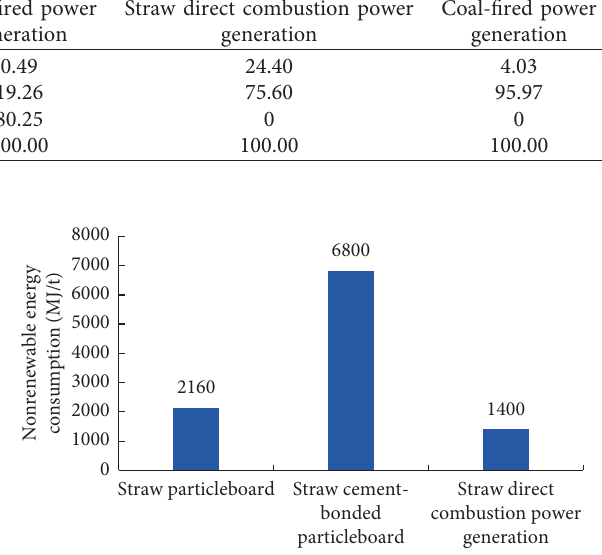
Figure 9: Comparison of nonrenewable energy consumption in Scenarios 1, 2, and